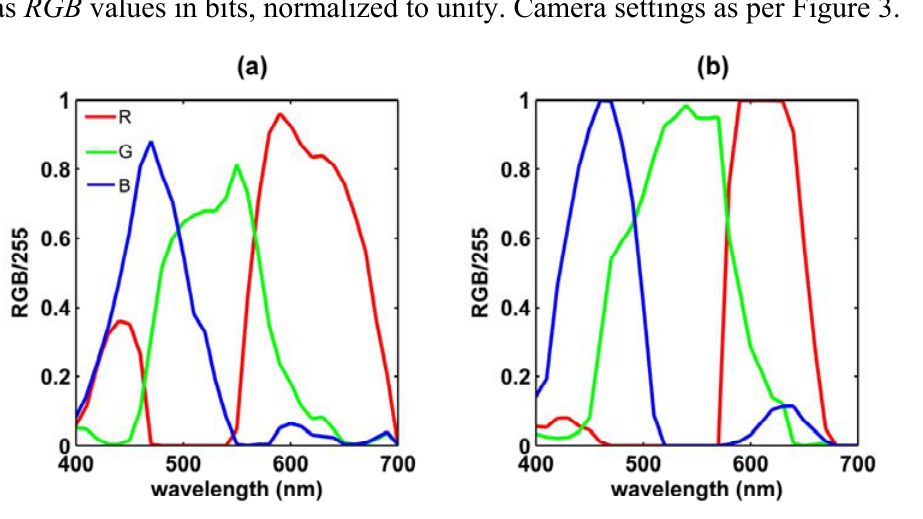
Figure 4. Response spectra of (a) CP885, and (b) ECOshot digital cameras. Response was defined as RGB values in bits, normalized to unity. Camera settings as per Figure